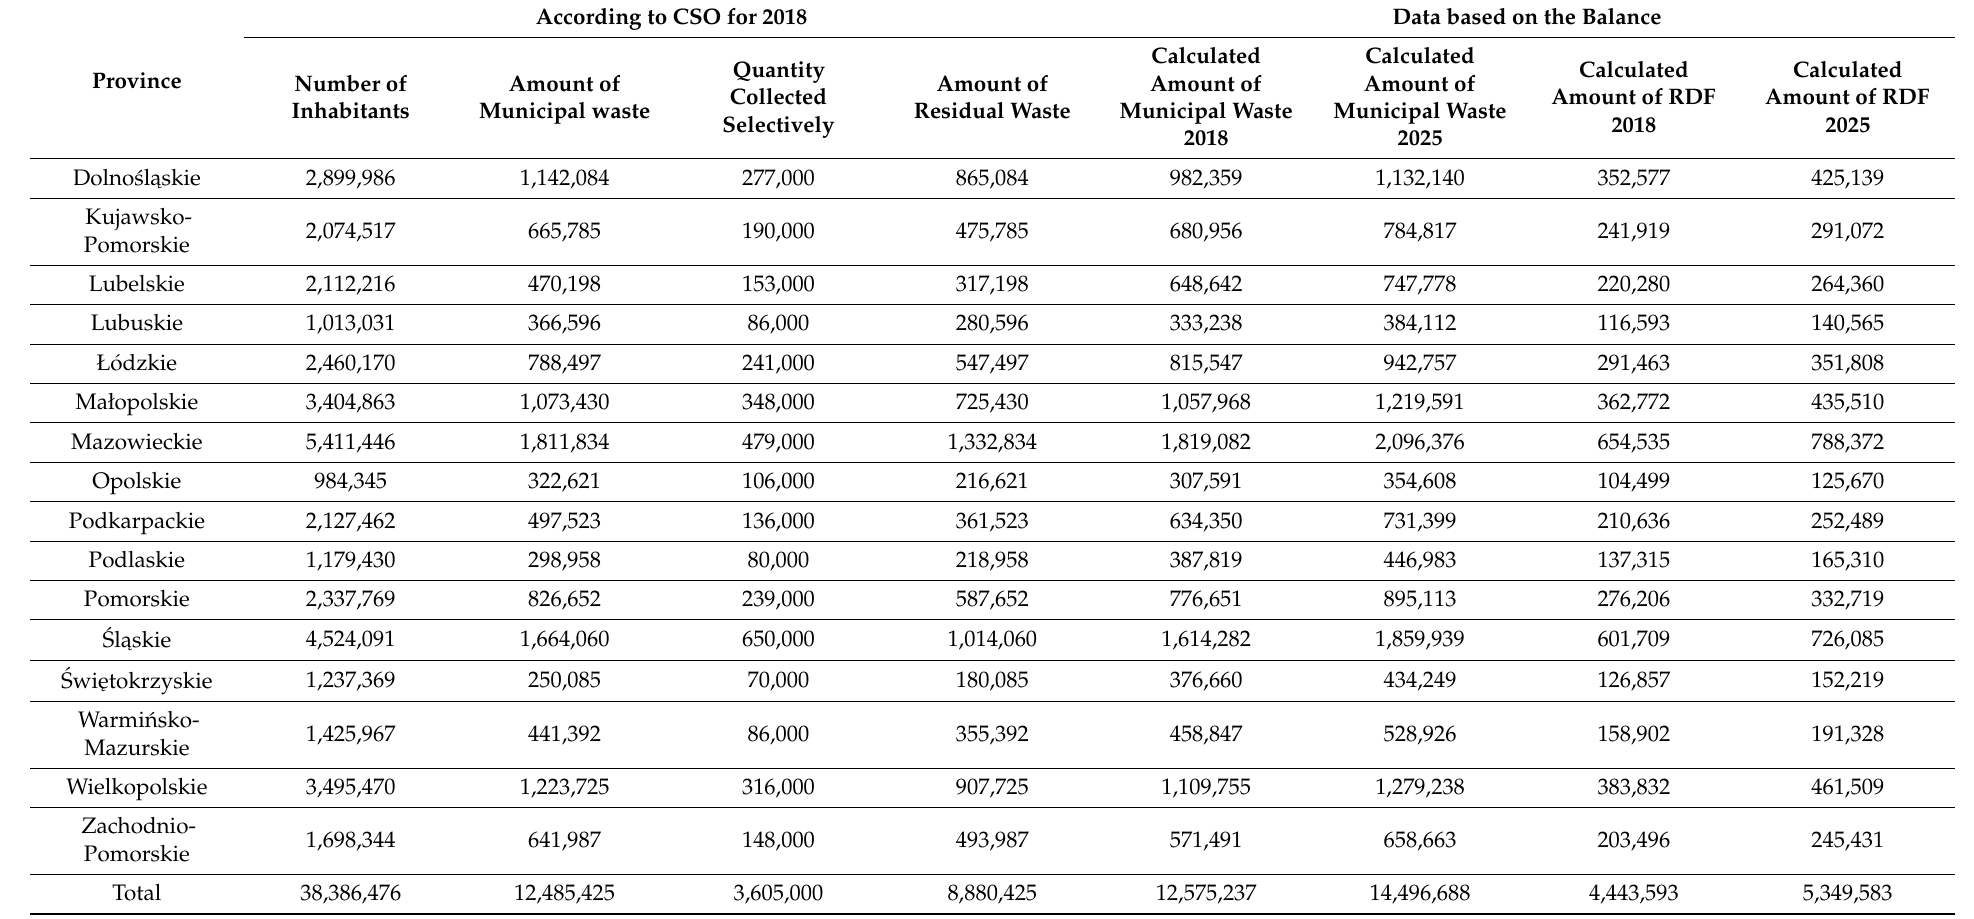
Table 7. Balance of municipal waste and RDF for 2018 with the perspective of 2025 based on CSO data and the authors’ own calculations. According to CSO for 2018 Data based on the Balance Calculated Calculated Quantity Calculated Province Number of Amount of Amount of Amount of Amount of Collected Amount of RDF Inhabitants Municipal waste Residual Waste Municipal Waste Selectively 2018